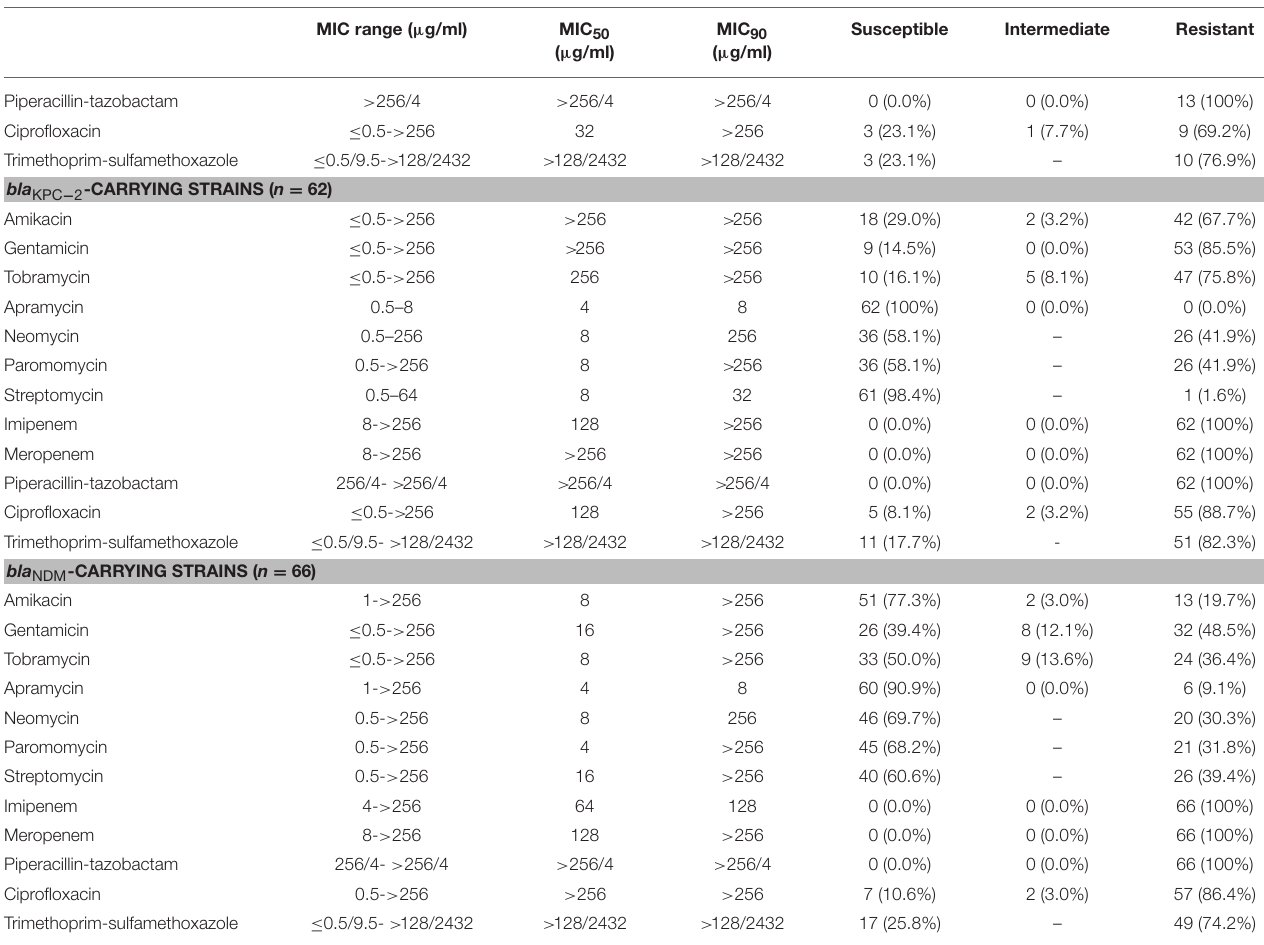
TABLE 3 | Genomic characteristics of the six apramycin-resistant CRE strains. Isolate Species ST Clean reads Clean bases (Gb) Contigs % GC content GenBank accession no ST6823